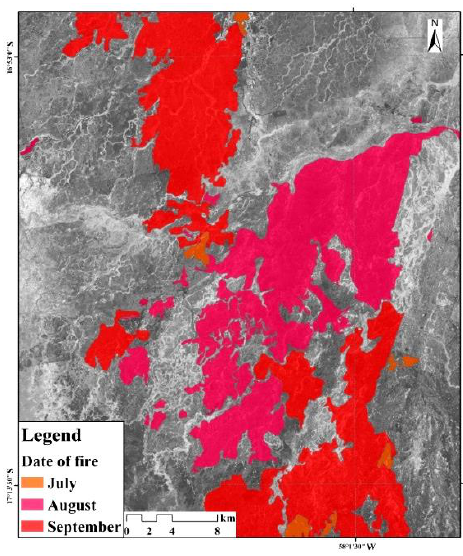
Figure 3. The comprehensive map of wetland fire sites, 2019.Note: Figure 3 is the superimposed map of fire sites in the study area, including the monthly burned fields in July, August and September. (2) Fire Severity